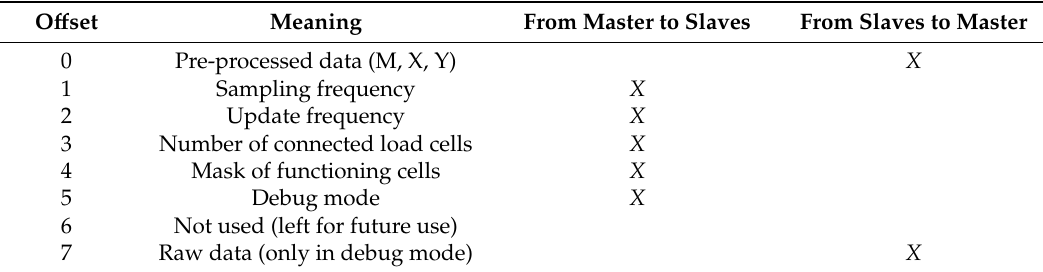
Table 2. CAN Message